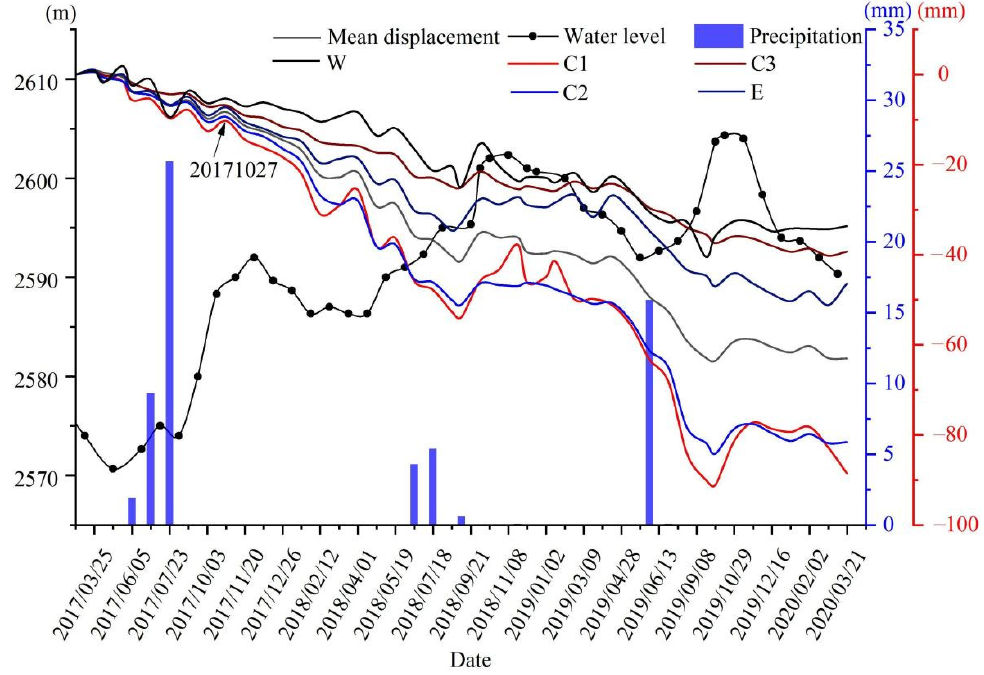
Figure 15. Time series of precipitation, water level, and deformation for the Chaxi landslide.